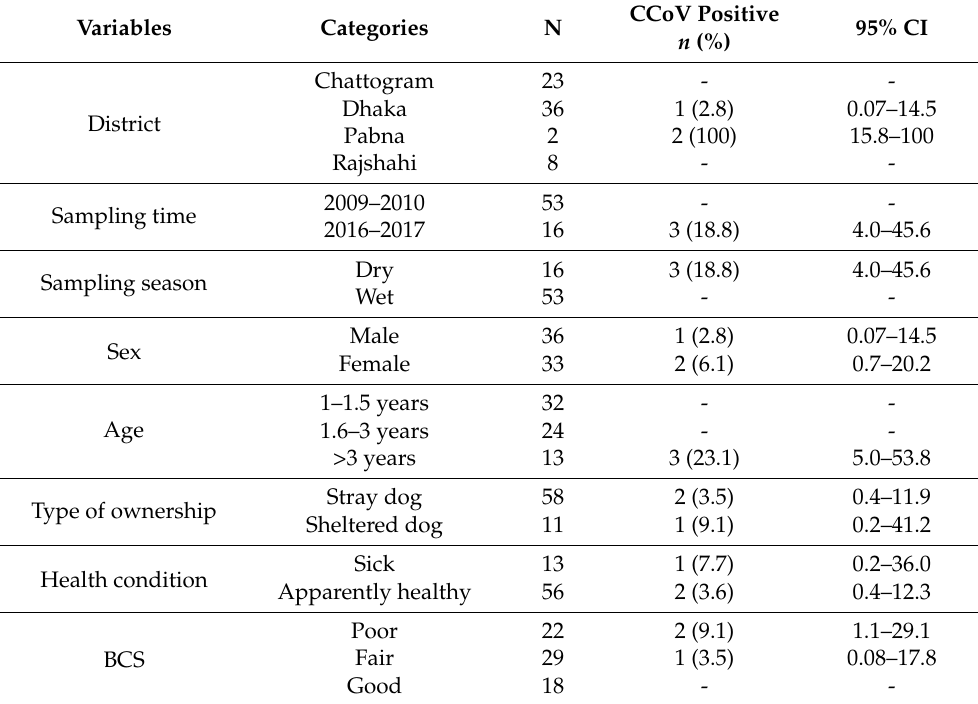
Table 1. Distribution of canine coronavirus in Dogs,